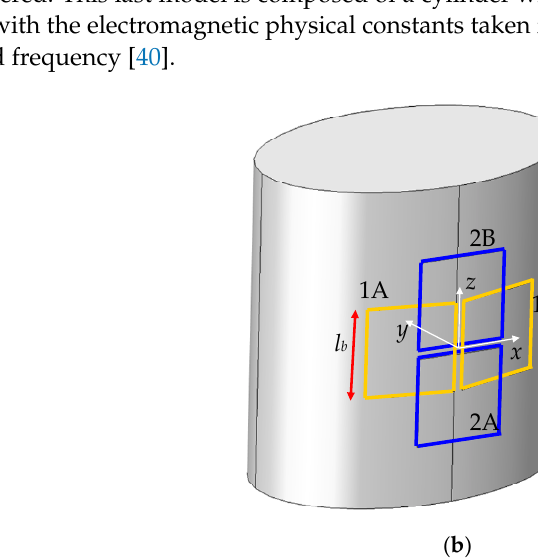
Figure 6. Proposed four coil array configuration ( a ) and application of the coil array on the human torso ( b ). torso ( b